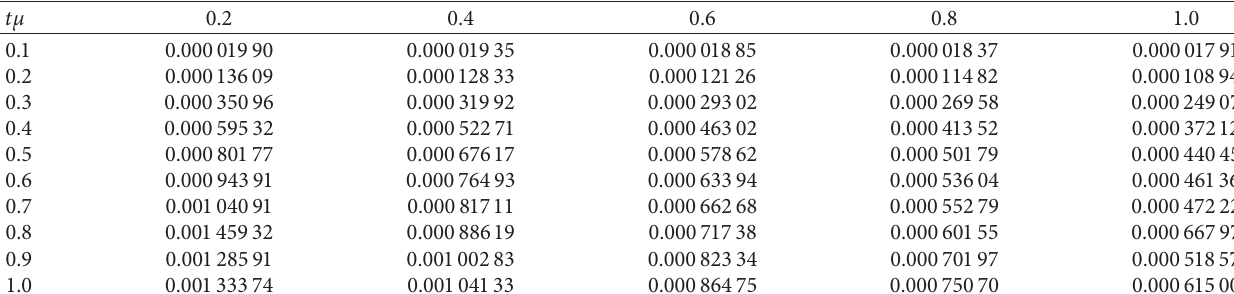
Table 4: Some values of w ( t, x ) for different values of μ for P � 1 (for a butyl B252